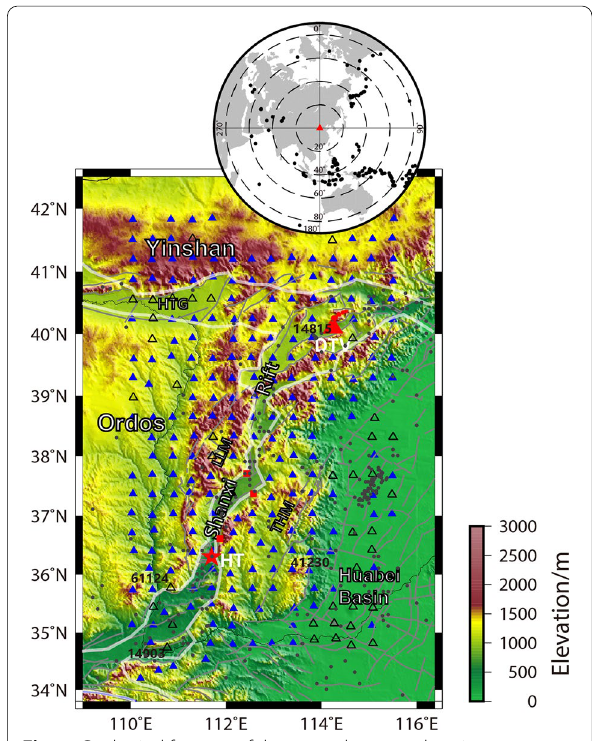
Fig. 1 Geological features of the research area and station distribution. The white dashed lines represent the boundaries of the tectonic units of the main blocks, the gray lines represent the distribution of faults, the black dots denote the historical earthquakes, the blue triangles represent the stations where crustal and Vp/Vs were obtained, the black triangles represent stations without such results, the red squares display permanent stations, and the red star represents the location of the Hongtong earthquake. HTG Hetao Graben, LLM Lvliang Mountains, THM Taihang Mountains, DTV Datong